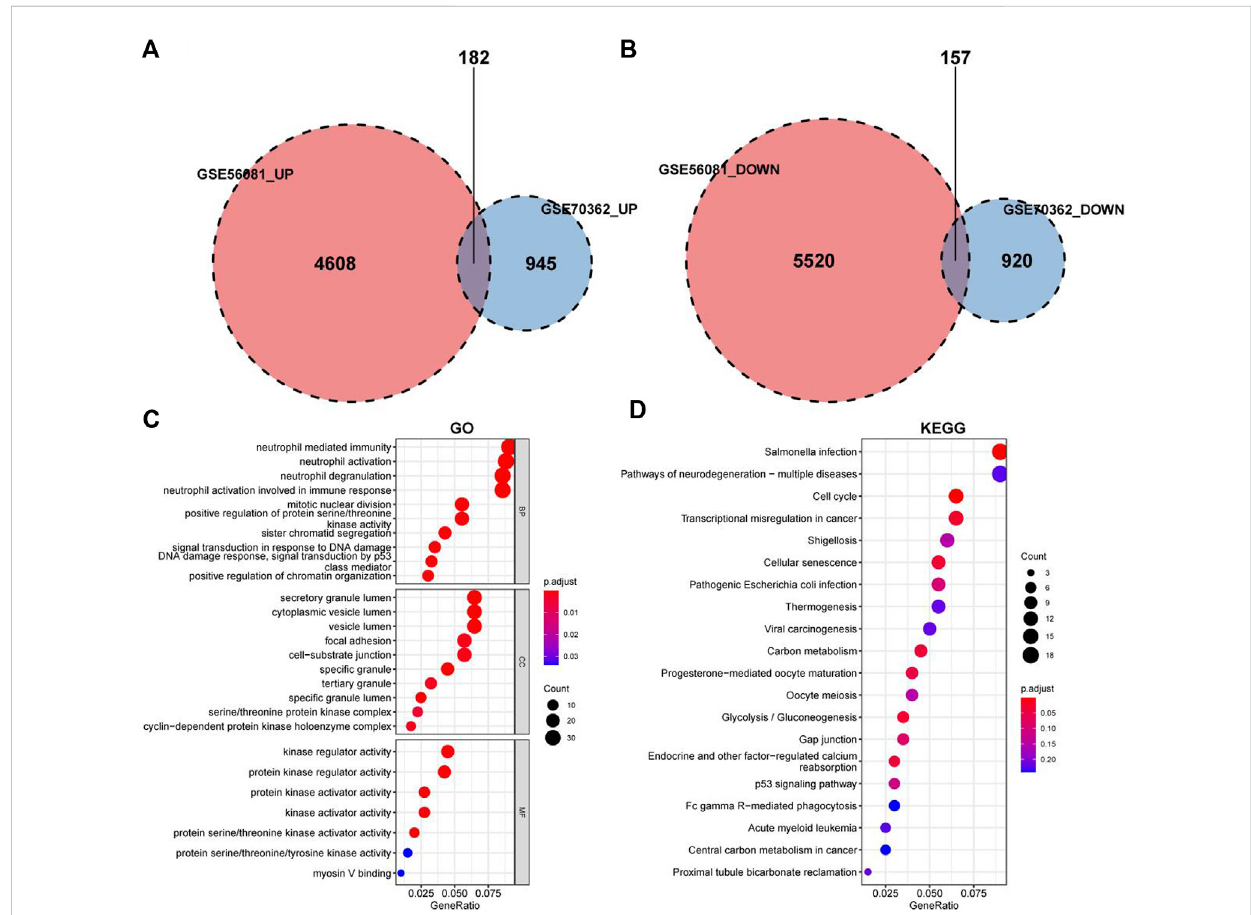
FIGURE 3 GOandKEGGenrichmentanalysis fortheIDD-relatedDEGs. (A) Differentialanalysisupregulated geneintersectioninGSE56081andGSE70362. (B) DifferentialgenedownregulationgeneintersectioninGSE56081andGSE70362. (C) GOtermsenrichedbythedifferentiallyexpressedIDD-relatedDEGs (MF:molecular function, BP:biological process and CC:cellular component). (D) KEGG pathways enriched by the differentially expressed IDD-related